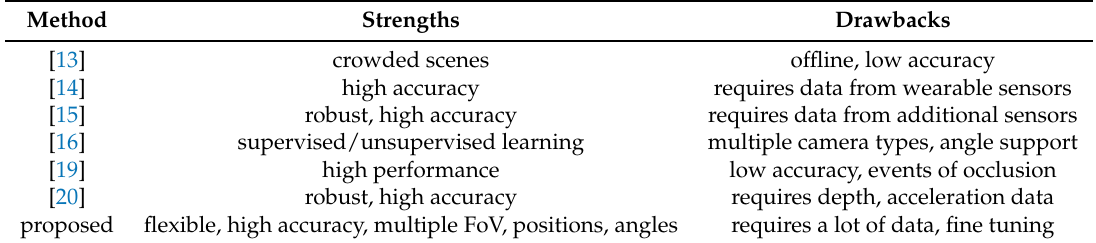
Table 1. Methods